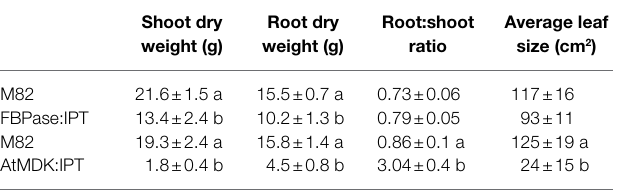
Data represent means (±SE) of six replicates of two independent experiments comparing each transgenic line with the control variety M82. Different lowercase letters indicate significant differences between the control and the respective transgenic plants by Student’s t-test, p < 0.05. TABLE 2 | Decline in photosynthetic rate with aging of source leaves of the control variety M82 and three independent transgenic tomato lines expressing Isopentenyltransferase ( IPT ) under the AtMDK (MDK:IPT) promoter.